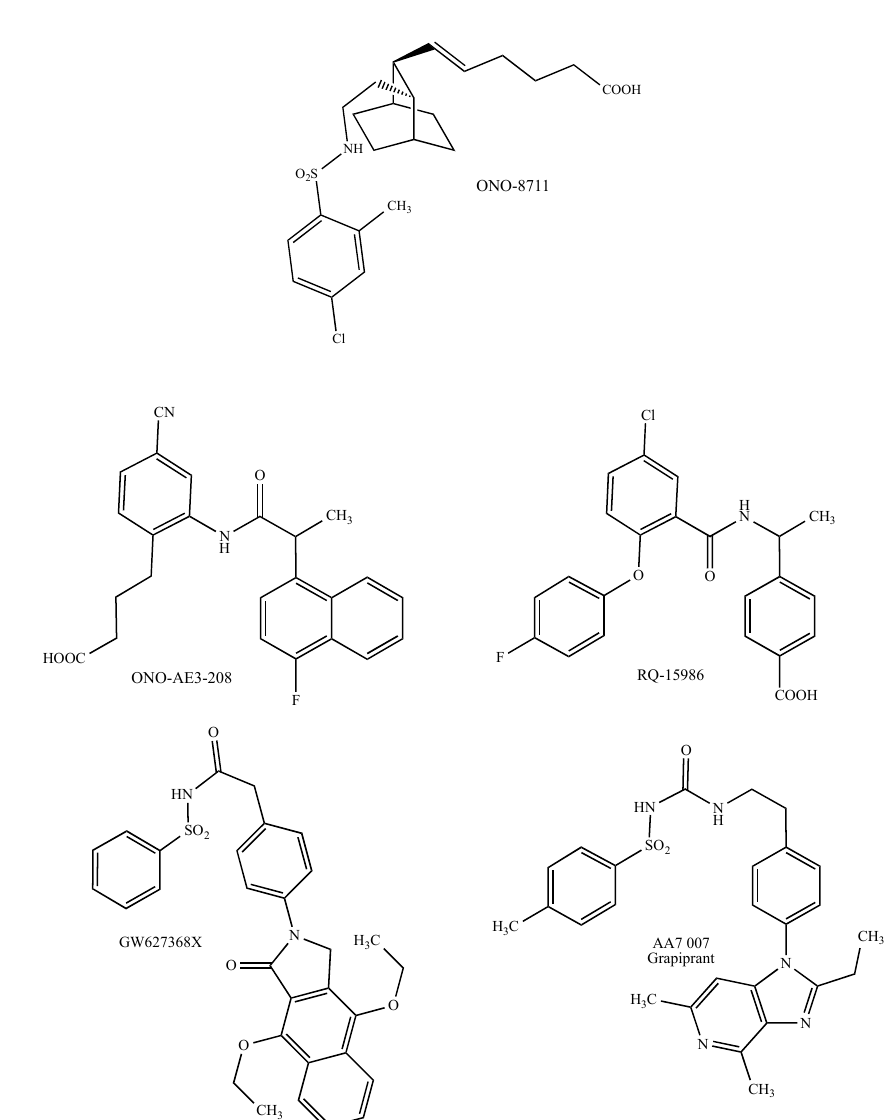
Figure 3. Structure of ( a ) EP1 and ( b ) EP4 antagonists.